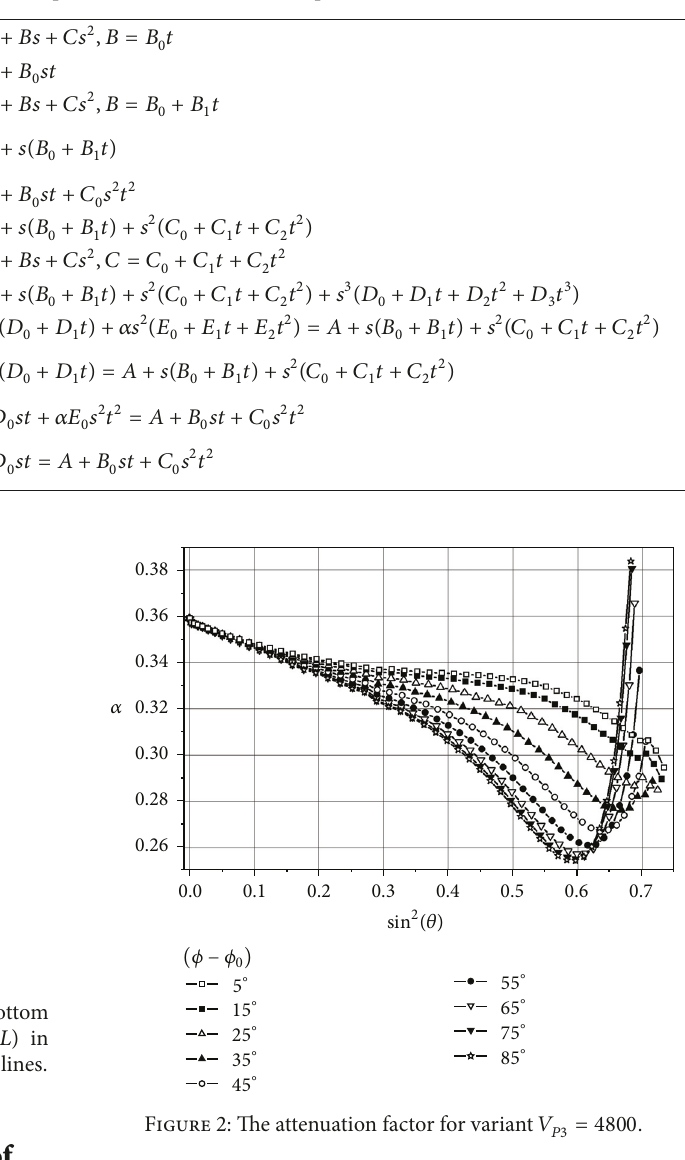
Table 1: Abbreviations, names, and equations of the QVOA techniques in issue.